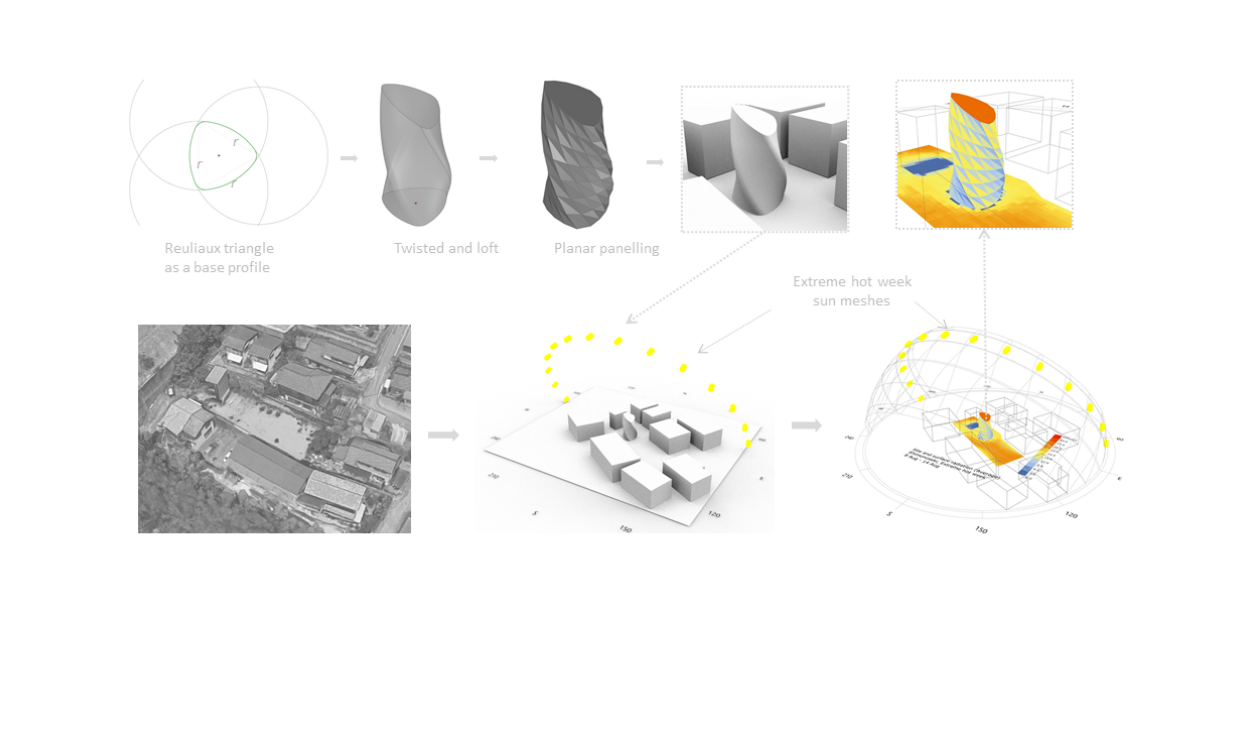
Fig. 3. The site and context, modeling, and analysis.